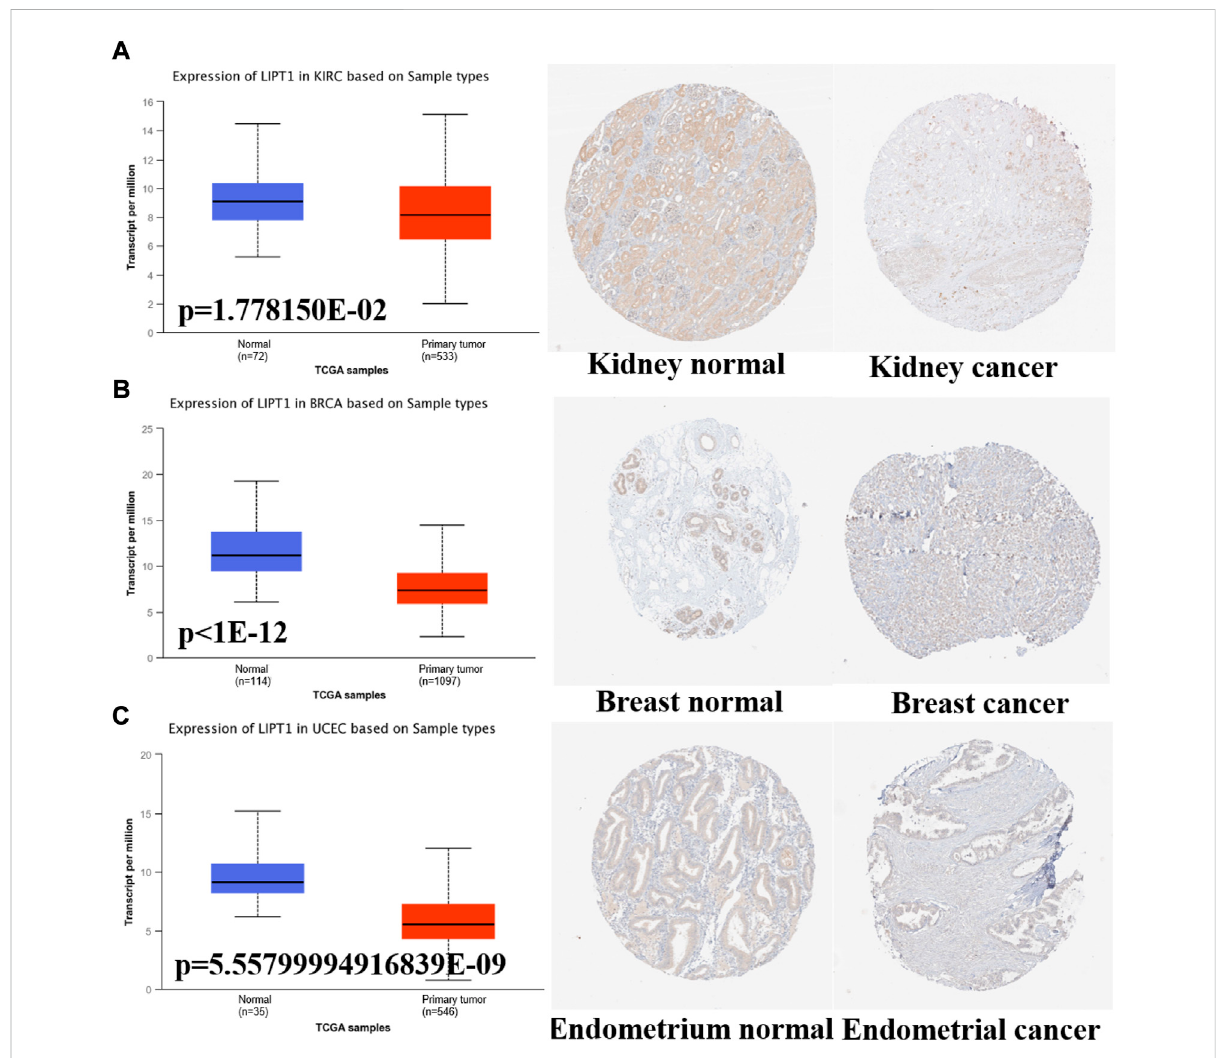
FIGURE 2 The different expression of LIPT1 between normal tissues and tumor tissues. (A – C) UALCAN and HPA platforms displayed the downregulated expression of LIPT1 in tumor tissue derived from kidney, breast and